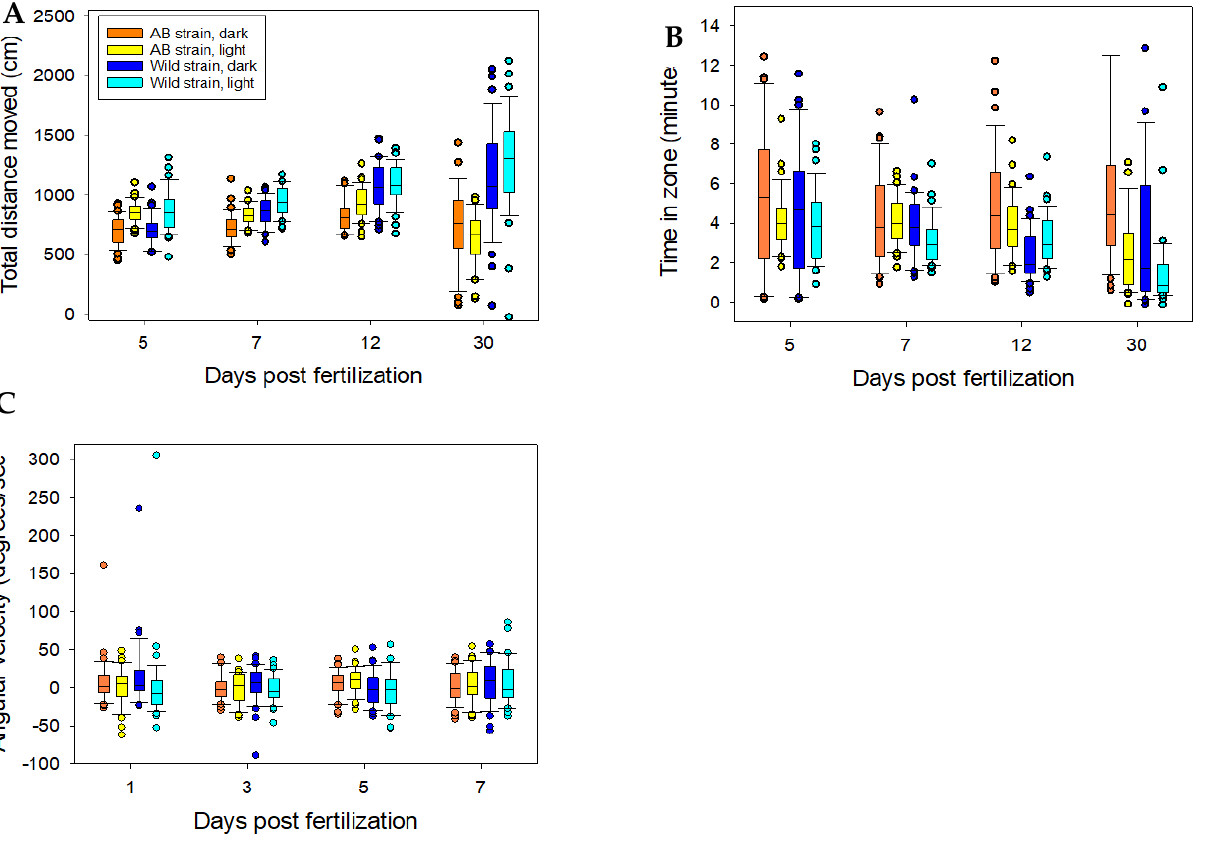
Figure 3. Behavioural variables from EthoVision, ( A ) total distance moved (cm), ( B ) time in zone (s) ( C ) angular velocity (degrees sec − 1 ). Data for zebrafish larvae at different days post fertilization. The centre line in the boxes represent the median value, the upper and lower end of the boxes third and first quartile, respectively. The bars represent the 5th and the 95th percentile and the circles outliers. For statistics see Table 2.